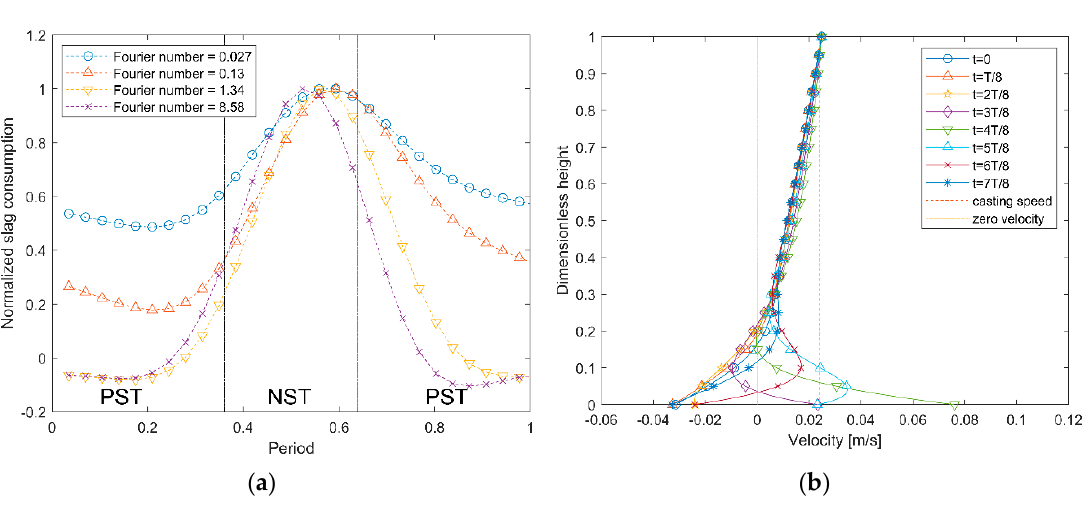
Figure 14. ( a ) Normalized slag consumption during the oscillation cycle with different Fourier numbers and ( b ) transient velocity profiles for Fo = 0.027 at meniscus (x =